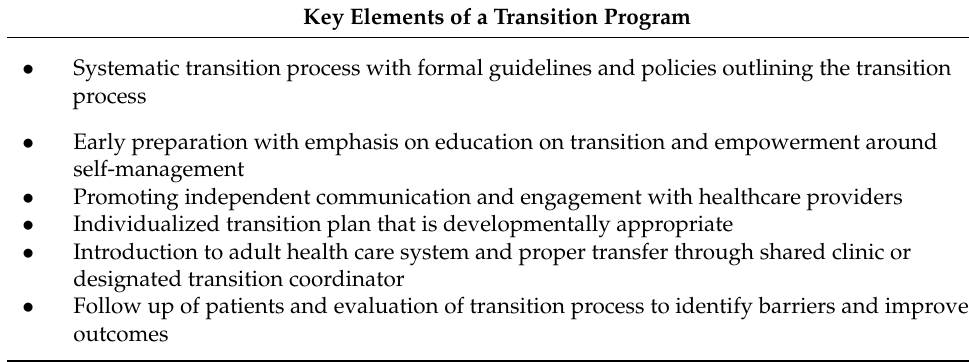
Table 1. Key elements of a transition